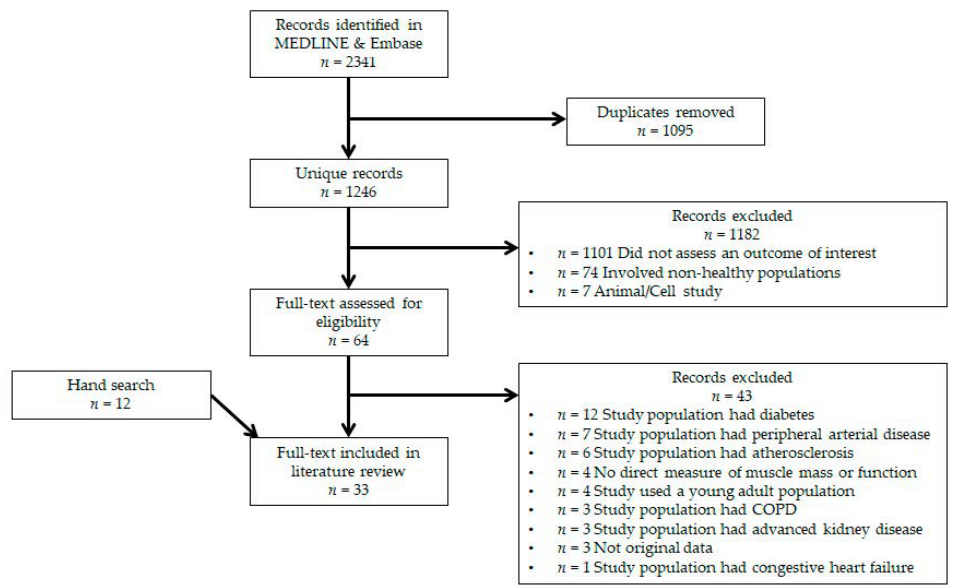
Figure 1. Study selection flow diagram.